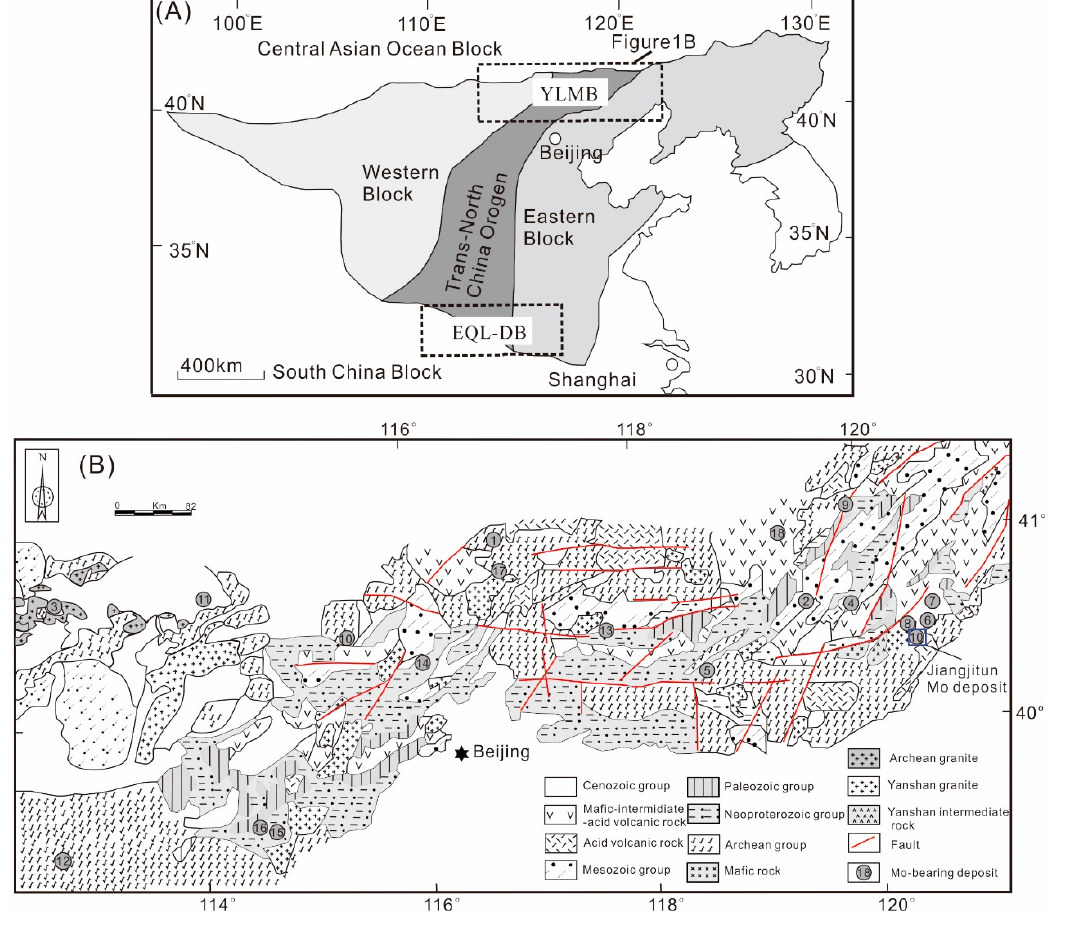
Figure 1. ( A ) The tectonic units of the North China Craton, including Eastern Block, Ttrans-North China Orogen, and Western Block (modified from Zhao et al., 2012 [12]); ( B ) schematic geological map showing the Yanshan–Liaoning molybdenum belt on the northern margin of North China Craton (modified from Zeng et al. 2012 and Shu et al., 2016). 1—Sadaigoumen; 2—Hekanzi; 3—Dasuji;